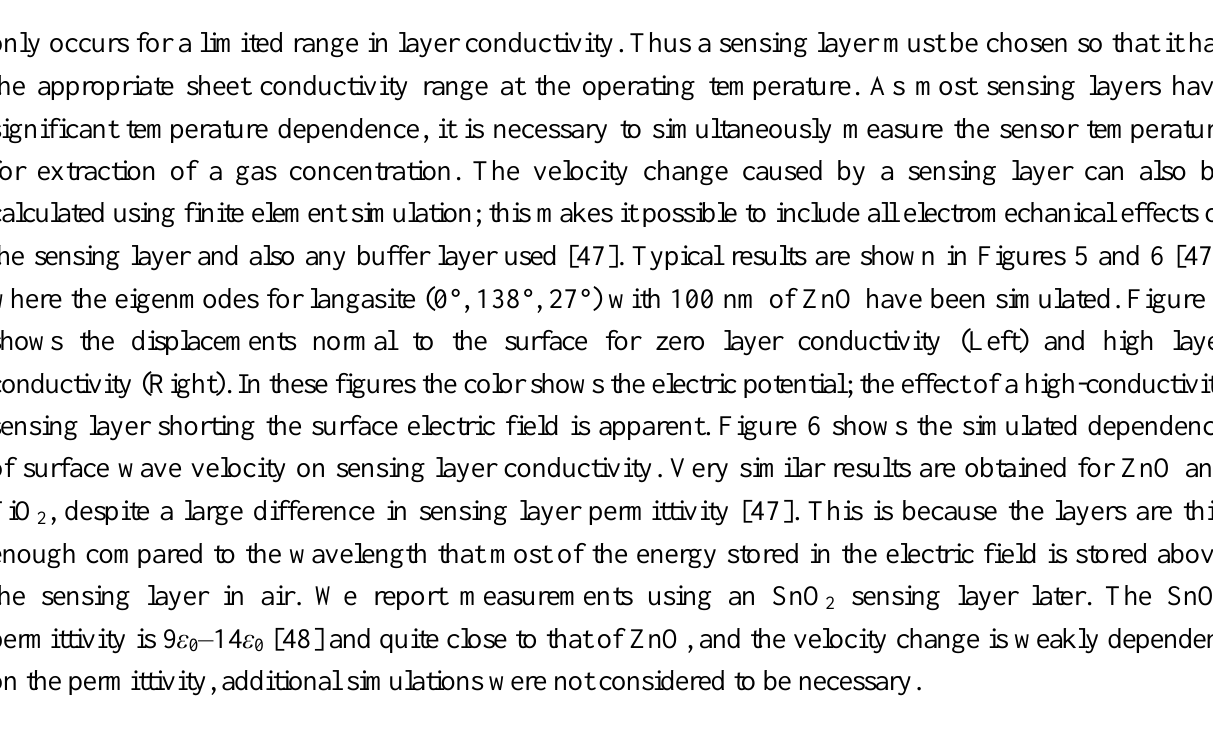
Figure 5. Simulated eigenmodes for 100 nm ZnO on langasite ( Left , 348.5 MHz) insulating surface layer and ( Right , 347.9 MHz) highly conductive surface layer. Color represents electric potential and the distorted shape is shown. A conductive surface layer shorts the electric field associated with charges induced on the